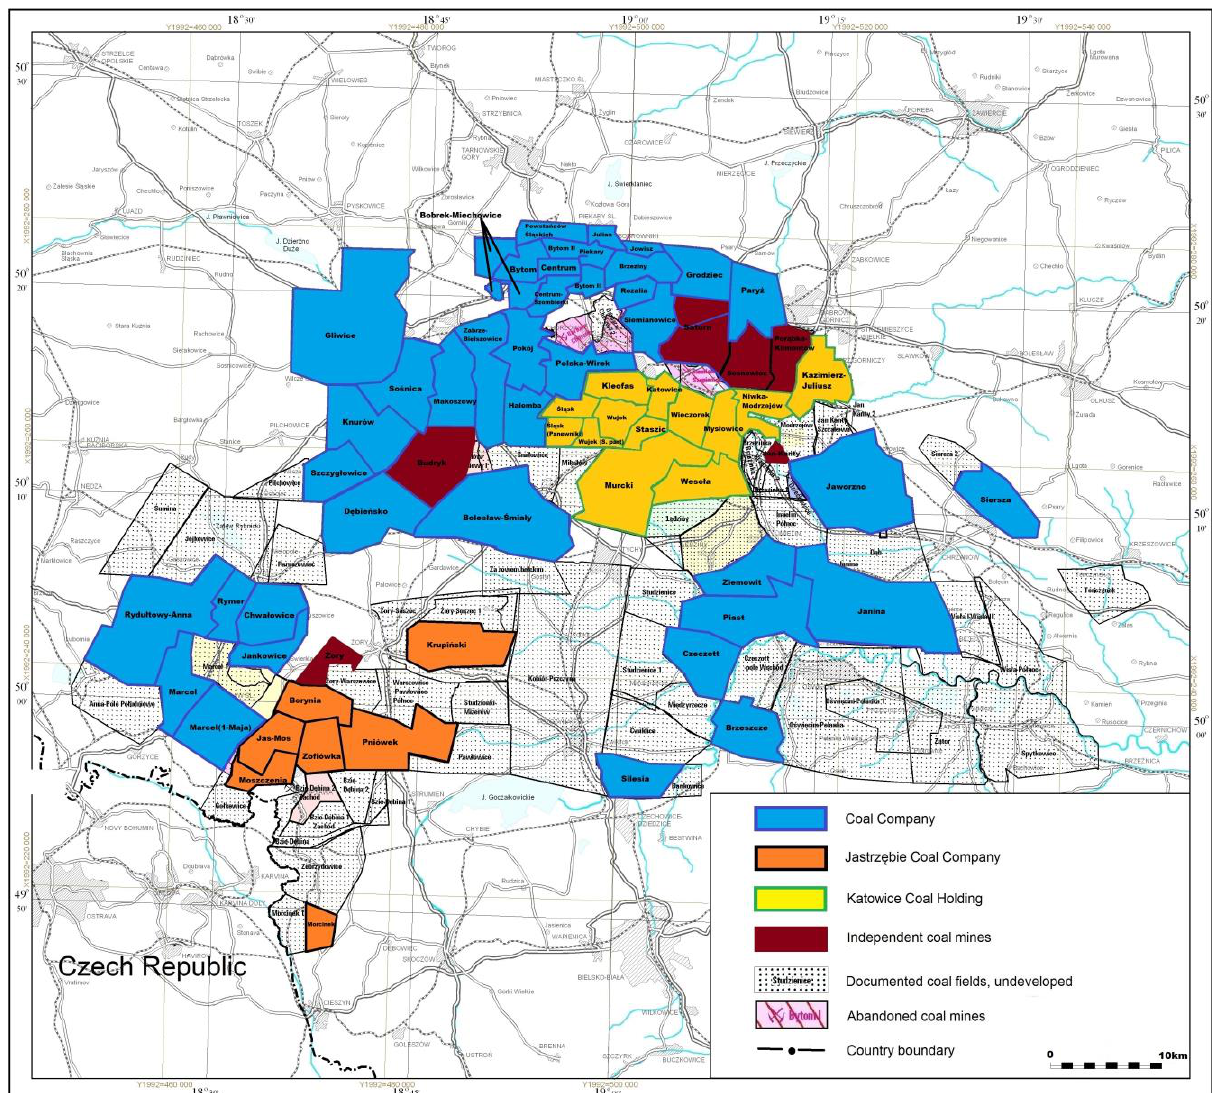
Fig. 1. Map of the coal companies and the arrangement of the coal deposits. in